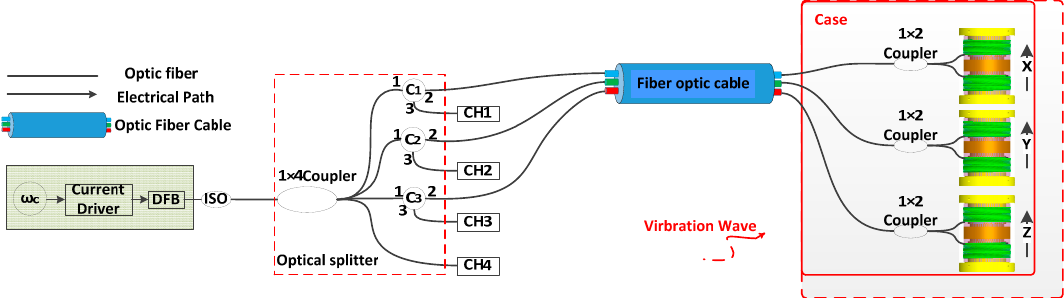
Figure 1. Tri-component optic fiber interference vibration detection system. ω c : Cosine signal with frequency of ω c ; DFB: distribute feedback laser; ISO: fiber-optic isolator; C1–C4: Circulator1– Circulartor4; CH1–CH4: four channels’ photodetectors and processor modules.